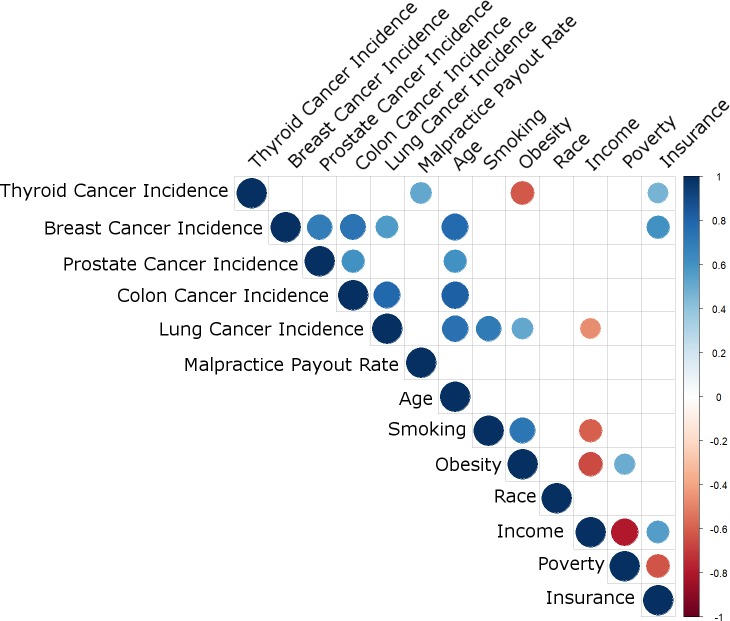
Correlation matrix including cancer incidences, malpractice payout rate, and cancer risk factors.Correlations are represented as colored circles, blue indicating positive correlation, and red indicating negative correlation. Larger circle size and greater color intensity indicate higher correlation coefficient (see color key). Blank space indicates the correlation was not statistically significant (Spearman correlation with Bonferroni correction, P < 0.05 considered significant). The complete correlation matrix is presented in S1 Table.